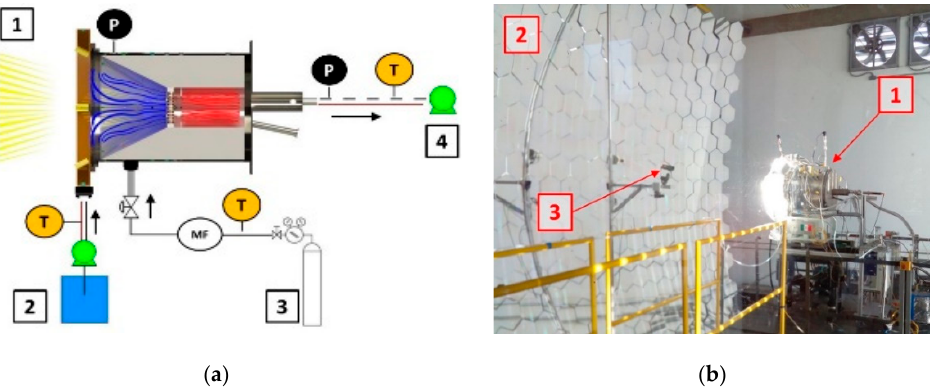
Figure 4. ( a ) Solar reactor operation diagram showing the temperature (T) and pressure (P) sensors, the mass flow controllers (MF), and the gas inlet/outlet, also is illustrated the incoming radiation flux (1), the water reservoir (2), the compressed air tank (3), and the air extractor (4). ( b ) The solar reactor installed in the high radiative flux solar furnace (HoSIER), the reactor (1), solar concentrator panel (2), and front pyrometer (3).